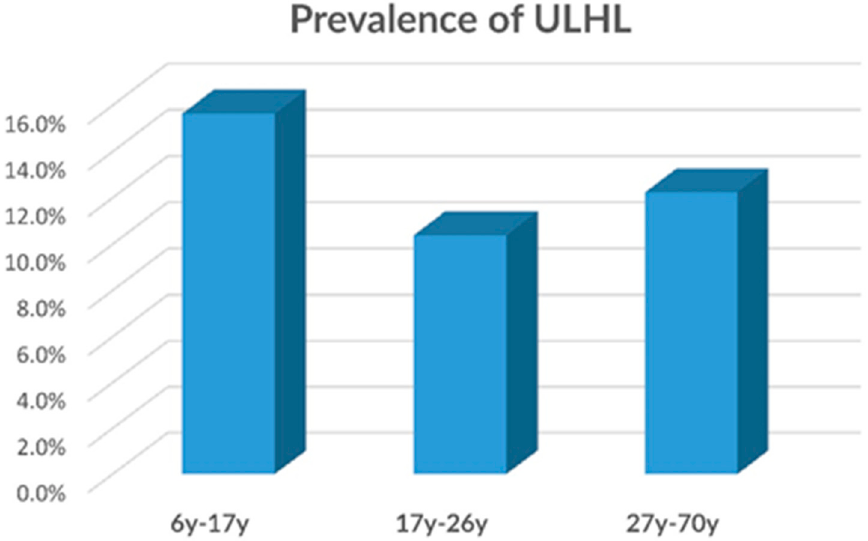
Figure 3. Prevalence of the ULHL according to three age groups, based on the first group survey (n = 643). No significant difference was found between the three age groups.